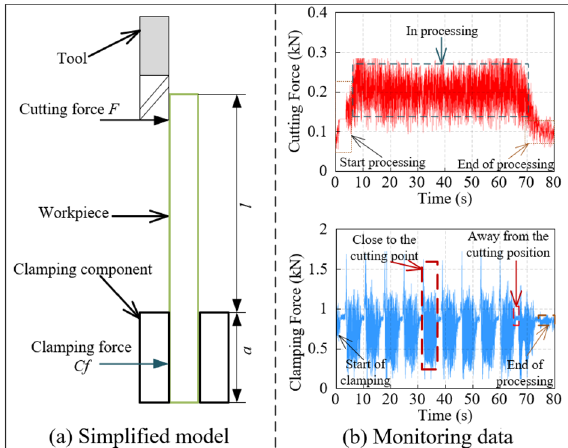
Figure 2. Explanation of spatio-temporal